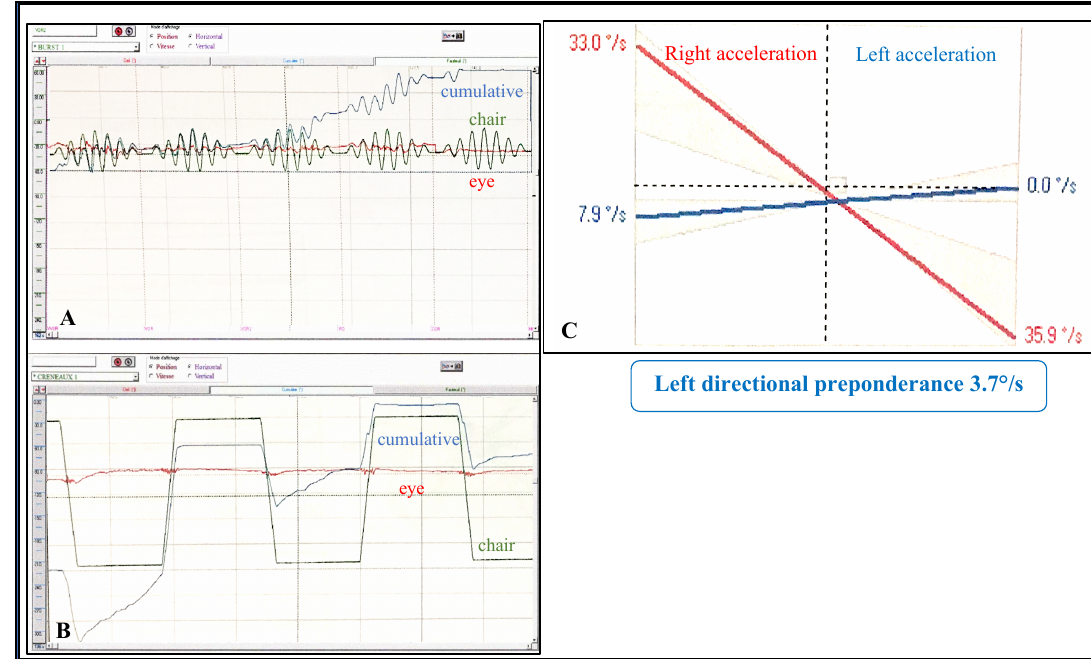
Figure 1. Results of a representative pathological kinetic test (patient 13). For method, see Supplementary Figure S3. ( A ) Sinusoidal harmonic acceleration test result. Green curve indicates rotatory chair sinusoidal movements; red curve indicates eye movement (nystagmus); blue curve is the cumulative result of movements of both eyes. The blue curve shows a more intense nystagmus when chair is rotated to the left side: the blue ascendant curve represents a left directional preponderance. ( B ) Impulsive rotational test. The three curves (green, red and blue) represent results of the same item but triggered by di ff erent stimuli: the rotatory chair moves with quick acceleration in one direction, is then stabilized and then moves with quick deceleration in the opposite direction, the so-called “creneau” stimulation. The blue ascendant curve shows a left directional preponderance. ( C ) Summary of impulsive rotational test results showing a significant left directional preponderance of over 2 ◦ per